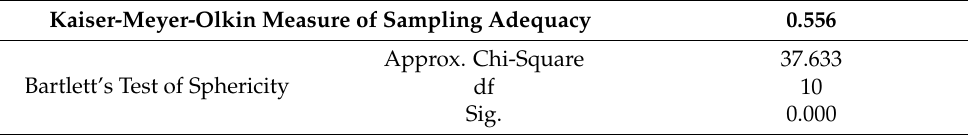
Table 4. KMO and Bartlett’s criterion, compiled by the authors KMO and Bartlett’s Test.